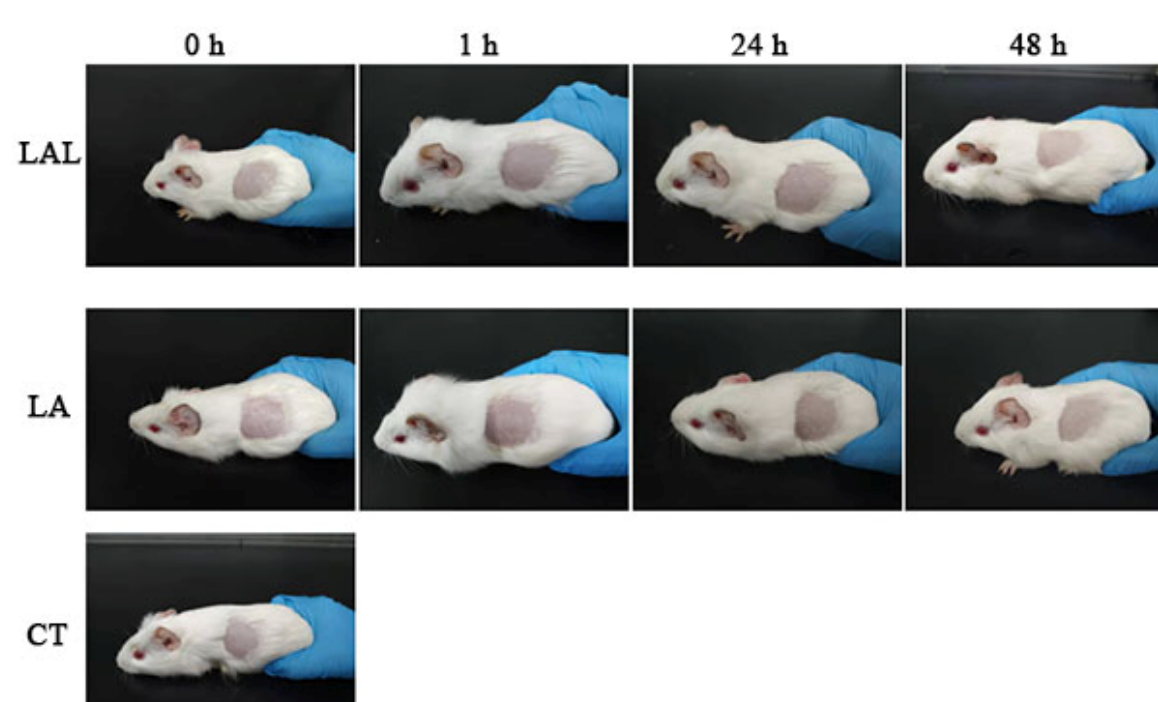
Figure 6. Intracellular distribution of free C6 and C6L micelles in B16F10 cells (scale bar: 10 μ m).